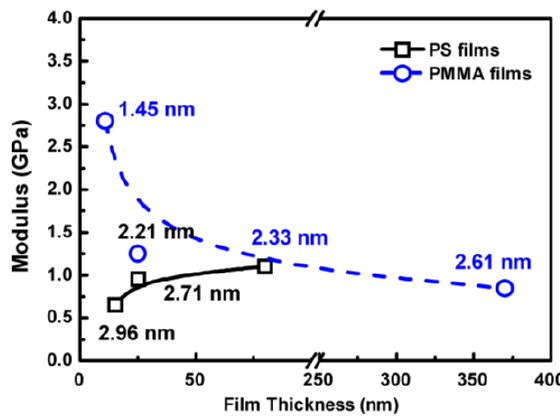
Figure 7. Calculated surface modulus of PS (at 80 °C) and PMMA (at 90 °C) films with different thickness. The number is the thickness of surface layer with the average modulus.